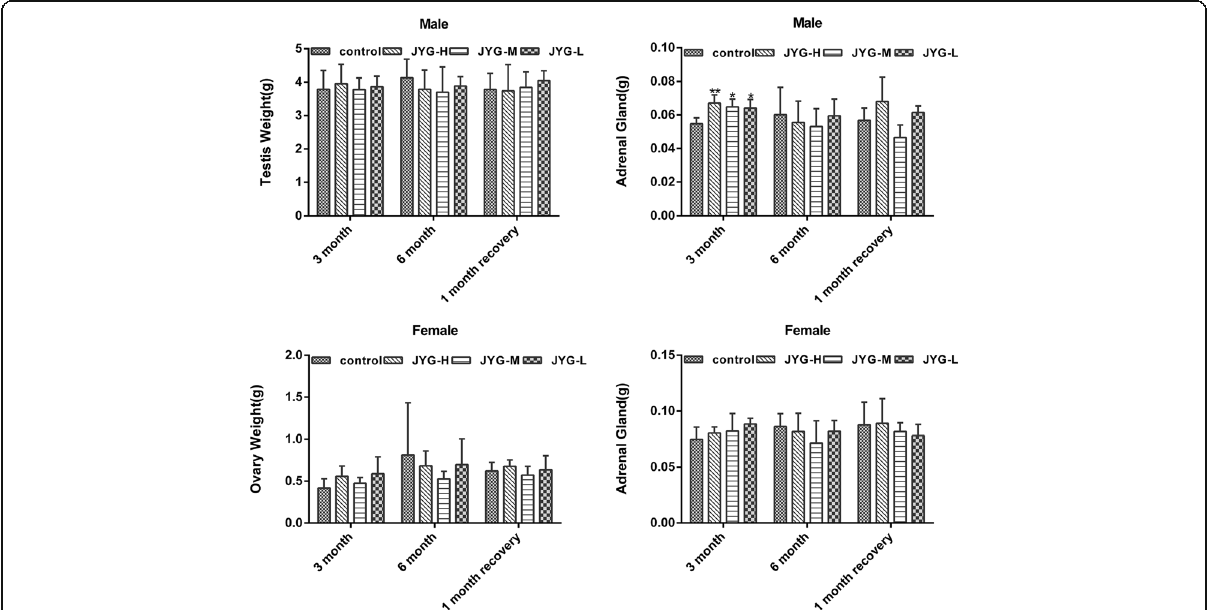
Fig. 5 Organs weight of testis, ovary, and adrenal gland in the control and JYG-treated groups in the chronic toxicity test. Note: JYG-H, JYG-M,JYG-L: Jueyin granules high-dose, medium dose, low-dose group, respectively. The values are expressed as mean±SEM (n=10 rats for 3 months; n=17 – 19 rats for 6 months; n=10 rats for 1 month recovery). * P <0.05; ** P <0.01 statistically significant compared to control group